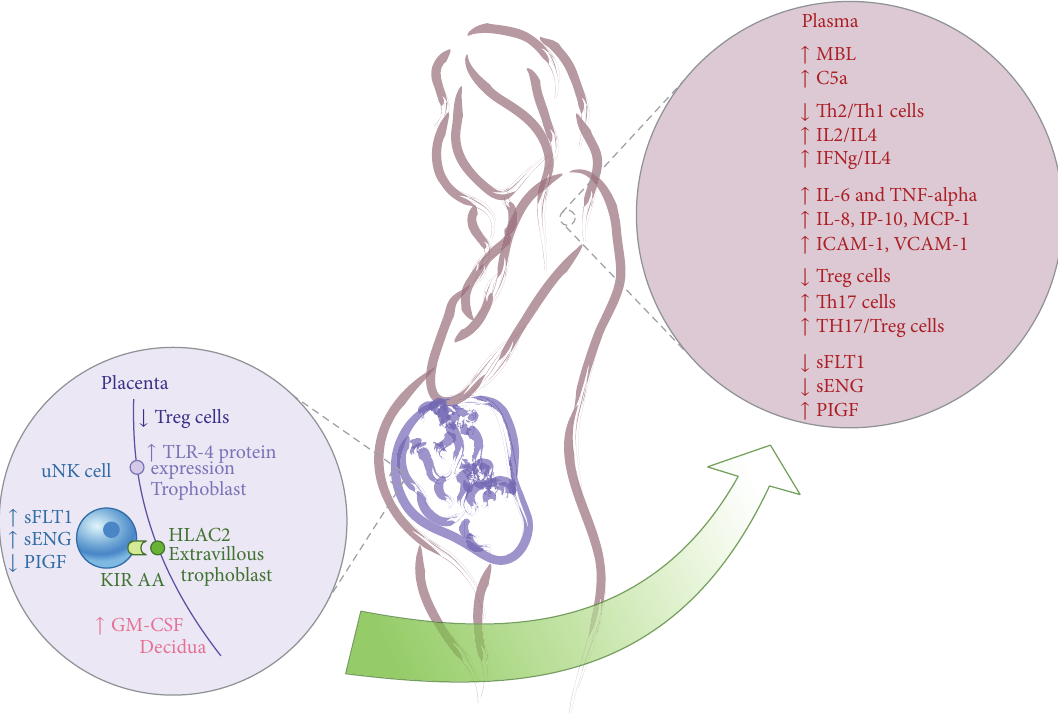
Figure 1: Maternofetal immune response in preeclampsia. A series of events occurs in the maternal-fetal interface in preeclampsia that result in an altered expression of different factors (PIGF, sENG, sFLT1, GM-CSF, and TLR-4) as compared to normal pregnancies. Similarly, the ratio among various populations of immune cells (Th17/Treg, Th1/Th2) differs from normality in preeclamptic patients. Regarding the complement system, preeclampsia enhances MBL and C5a synthesis. These changes are evidenced in peripheral blood in which the proinflammatory systemic environment is also seen with high IL-6 a, TNF-alpha, IL-8, IP-10, MCP-1, ICAM-1, and VCAM-1 levels. Treg: